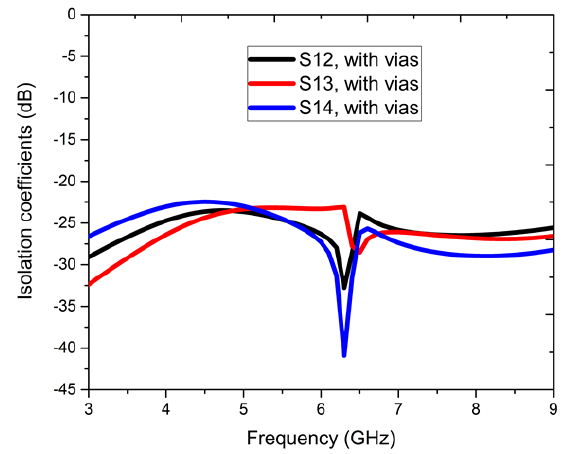
Figure 8. Isolation parameters, dB with vias for the four-element antenna